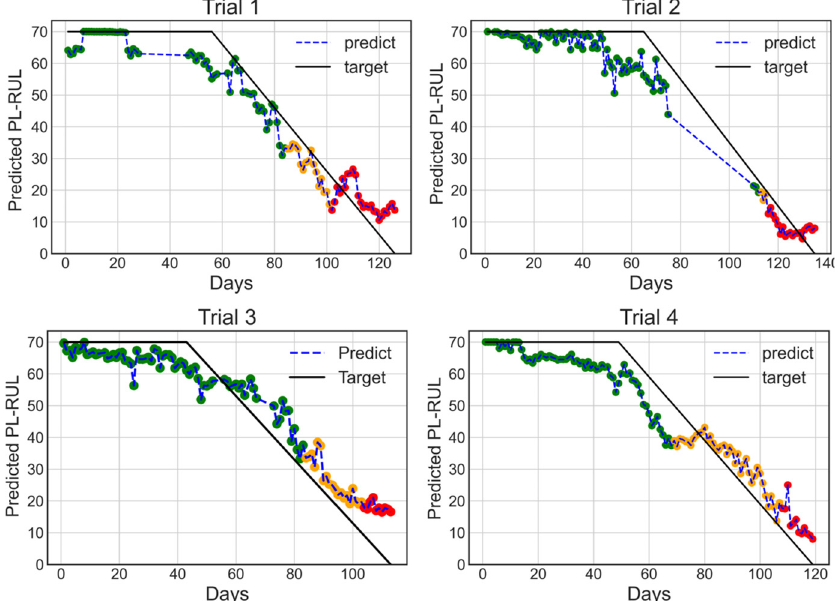
70 T days for trials 1 to 4, Trained on features RUL